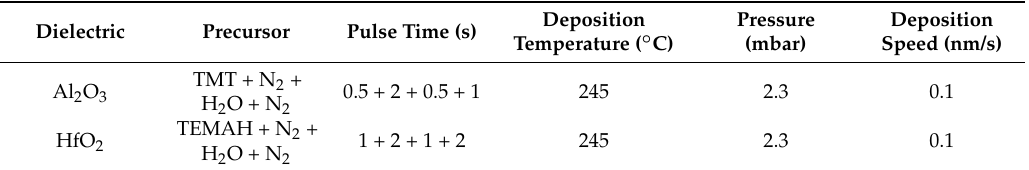
Table 1. ALD process to prepare the HfO 2 –Al 2 O 3 dielectric.